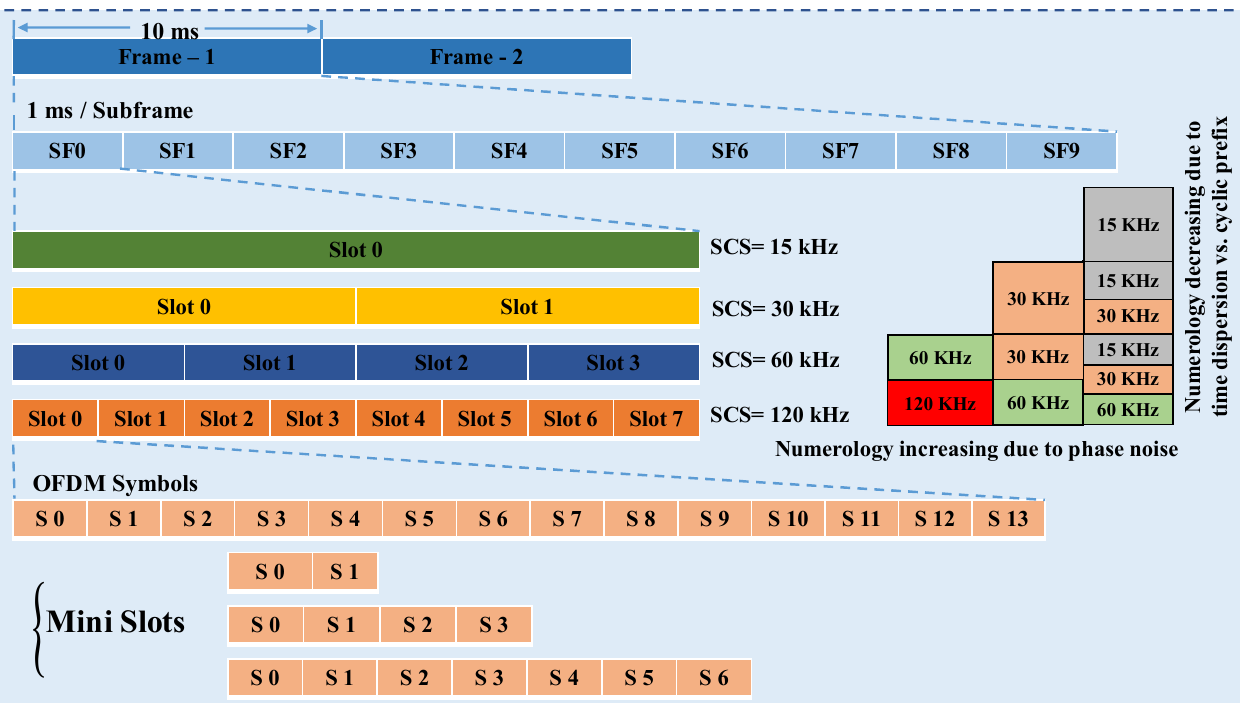
Figure 7. Fifth-generation frame, subframe, and subcarrier